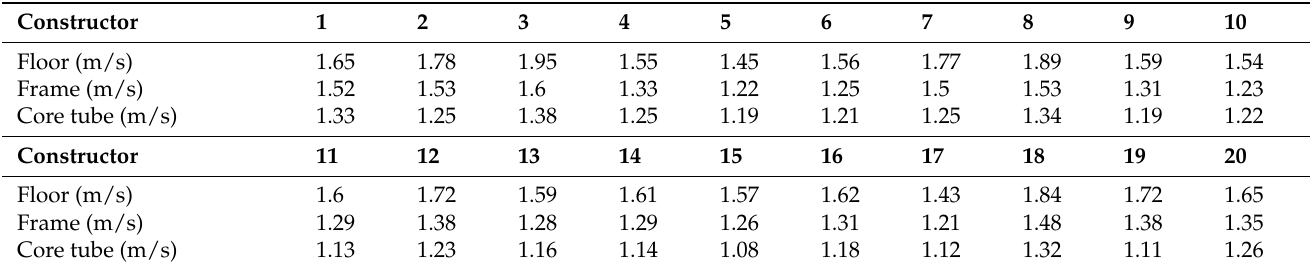
Table 1. Results of evacuation speed in different working